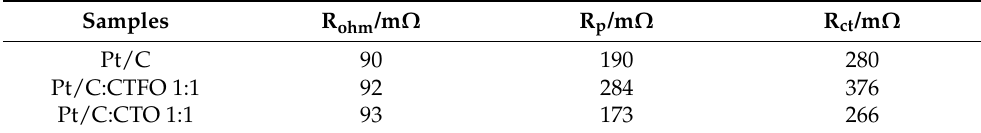
Table 4. Resistance values for all catalyst compositions from EIS at 0.6 V under 80% RH and at 80 ◦ C. Samples R ohm /m Ω R p /m Ω R ct /m Ω Pt/C 90 190 280 Pt/C:CTFO 1:1 92 284 376 Pt/C:CTO 1:1 93 173